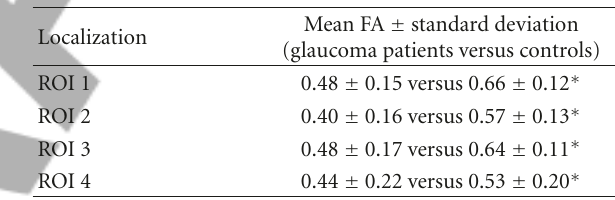
Table 2: Averaged FA values in di ff erent ROIs of glaucoma patients and